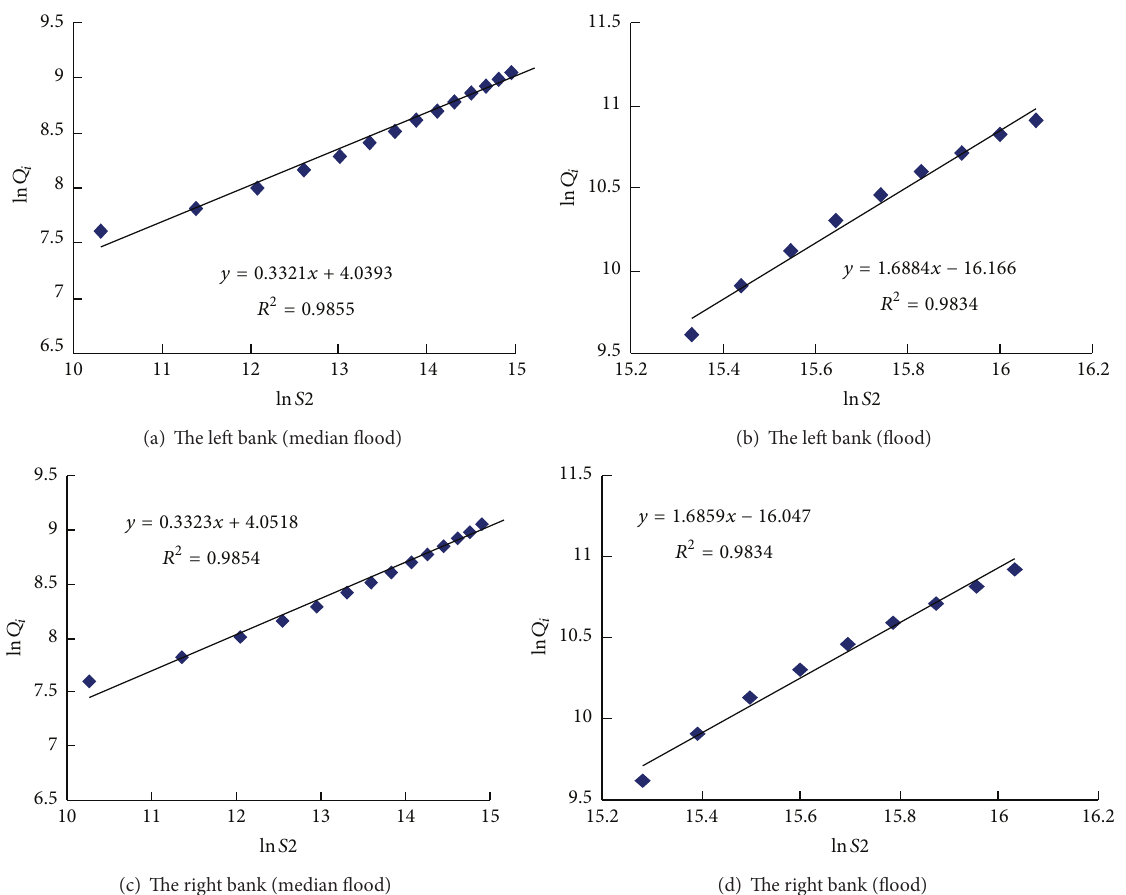
Figure 4: Second-order accumulated variable-dimensional fractal sequence of Chongqing city of Yangtze River.